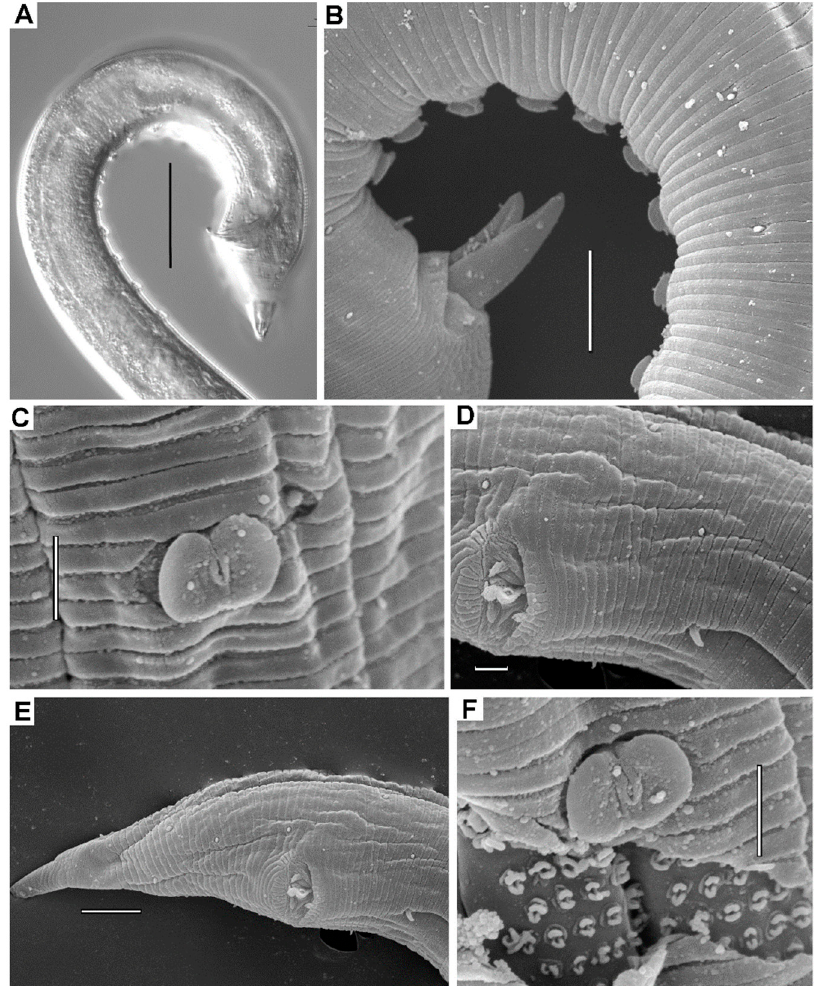
Figure 6. Gammanema okhlopkovi sp. n., posterior body, males: ( A ) hind body; ( B ) spicule tips, precloacal seta, and supplementary organs, lateral view, scanning electron micrograph; ( C ) posterior-most supplementary organ, scanning electron micrograph; ( D ) cloacal opening and precloacal seta, subventral view, scanning electron micrograph; ( E ) tail with sensory papillae; ( F ) damaged cuticle near a supplement displays struts in the median zone, scanning electron micrograph. Scale bars: ( A ) 50 μ m, ( B ) 10 μ m, ( C ) 3 μ m, ( D ) 3 μ m, ( E ) 10 μ m, ( F ) 3 μ m.